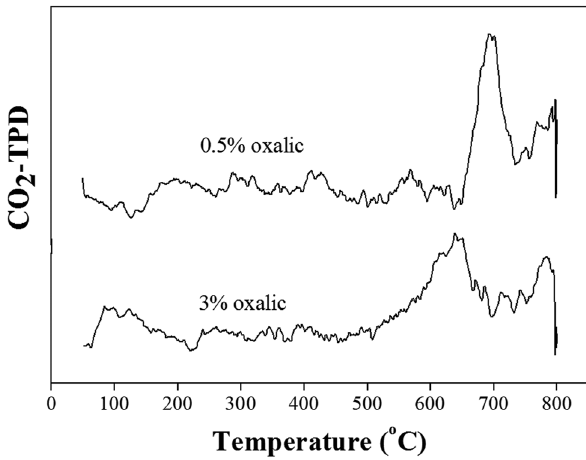
Figure 3: CO 2 desorption of CeO 2 synthesized using a 3% oxalic concentration at a 400 rpm stirring rate.